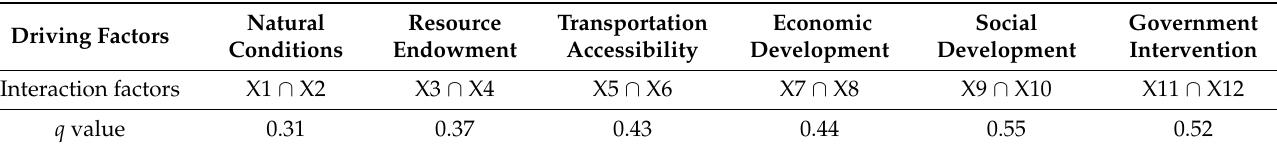
Table 5. Interaction effect detection results of different driving factors in the